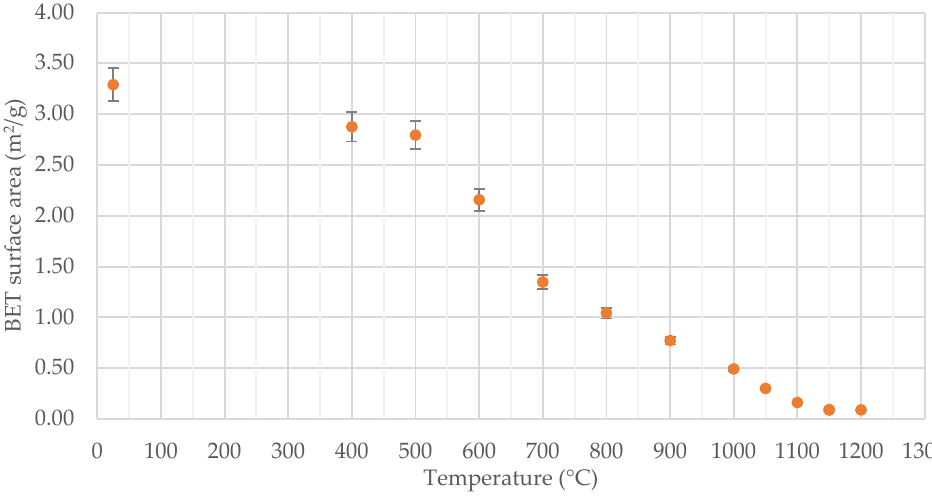
Figure 1. Calculated surface area changes due to sintering of LMS-1 simulant.